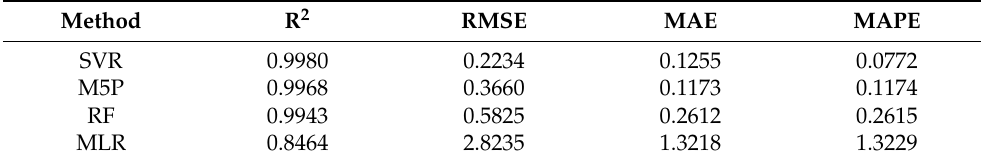
Table 3. Test results of the Feitsui Reservoir water level prediction.